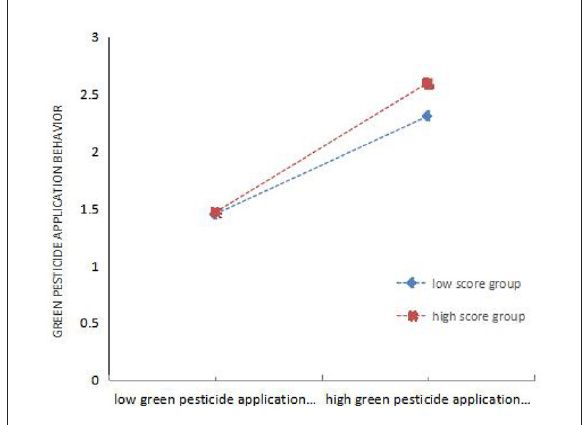
TABLE 11 Market adjustment guidance test.